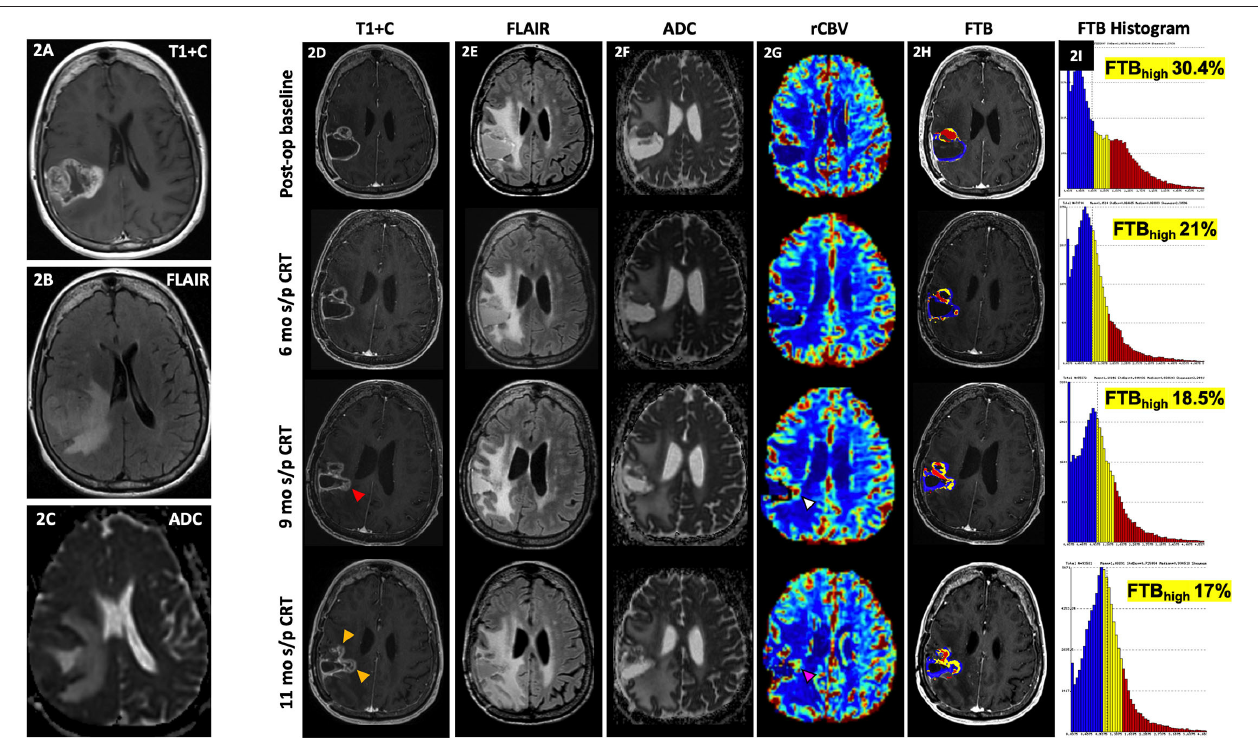
FIGURE 2 | Delayed pseudoprogression. A 71-year-old female with GBM (IDH wt, MGMT + ) initially presented with an enhancing right parietal mass (A) with extensive locoregional mass effect, perilesional FLAIR hyperintensity (B) , and diffusion restriction (C) . Her post-op baseline MR showed mild peripheral enhancement of the resection cavity most pronounced at the anterior aspect [ (D) , top row] with associated perilesional FLAIR hyperintensity [ (E) , top row], and some diffusion restriction [ (F) , top row] and increased rCBV [ (G) , top row]. At 6 mo s/p CRT, there is persistent peripheral enhancement of the resection cavity [ (D) , 2nd row] with slightly increased FLAIR hyperintensity [ (E) , 2nd row], less prominent diffusion restriction [ (F) , top row], and similar to slightly decreased rCBV [ (G) , 2nd row). At 9 mo s/p CRT, there is mildly increased enhancement at the medial aspect of the resection cavity [ (D) , 3rd row, red arrowhead) with similar perilesional FLAIR hyperintensity [ (E) , 3rd row], less prominent diffusion restriction [ (F) , 3rd row], and slightly increased rCBV [ (G) , 3rd row, white arrowhead]. At 11 mo s/p CRT, there is mildly increased nodular enhancement at the medial aspect of the resection cavity [ (D) , 4th row, yellow arrowhead], increased perilesional FLAIR hyperintensity [ (E) , 4th row], similar to mildly increased diffusion restriction [ (F) , 4th row], and increased rCBV [ (G) , 4th row, pink arrowhead]. From her post-op baseline scan to the 11 mo s/p CRT time-point, areas of high fractional tumor burden (FTB high ) , within the lesion as reflected by the red areas within the lesion, visually show gradual decrease over time [ (H) , in order from top to bottom rows], which is also supported by the progressive quantitative decrease in FTB high percentages over time as shown on the corresponding histograms [ (I) , in order from top to bottom rows]. Despite mild worsening of conventional MR findings, the gradual decrease in FTB high suggests treatment effect rather than progression. Resection of the lesion was nonetheless performed, and histopathology demonstrated necrosis. Since the worsening of conventional MR findings occurred > 3 months after CRT, this is considered delayed Psp or treatment necrosis. ADC, apparent diffusion coefficient; ASL, arterial spin labeling; CRT, chemoradiotherapy; FLAIR, fluid-attenuated inversion recovery; FTB, fractional tumor burden; GBM, glioblastoma; IDH, isocitrate dehydrogenase; MGMT, O-6-methylguanine-DNA methyltransferase; mo, months; op, operative; Psp, pseudoprogression; rCBV, relative cerebral blood volume; s/p, status post; T1 +